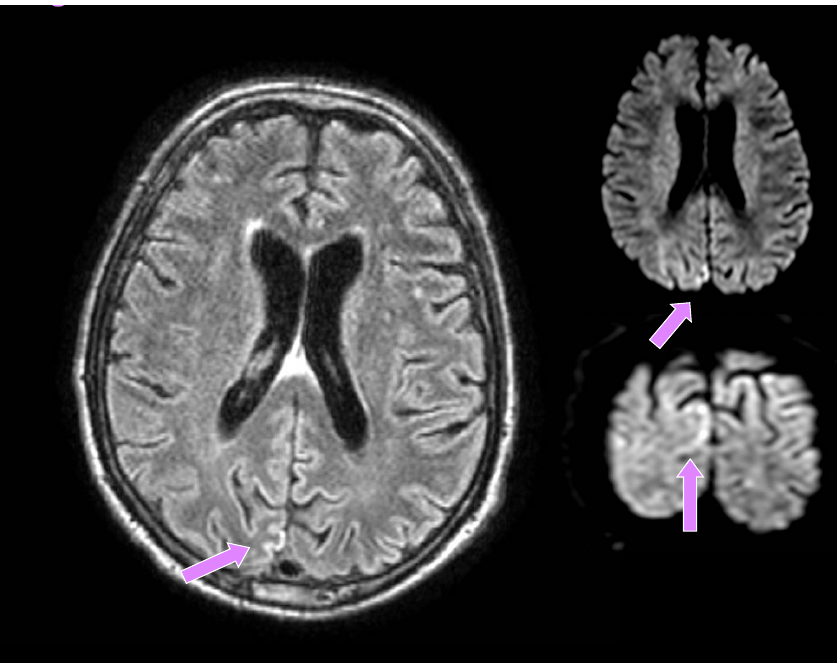
Figure 1. Brain MRI: altered signal in the occipital region, mainly parasagittal on the right, much less evident and shaded in the contralateral site (Seq. FLAIR, Axial and Coronal DWI), highlighted by pink arrows.